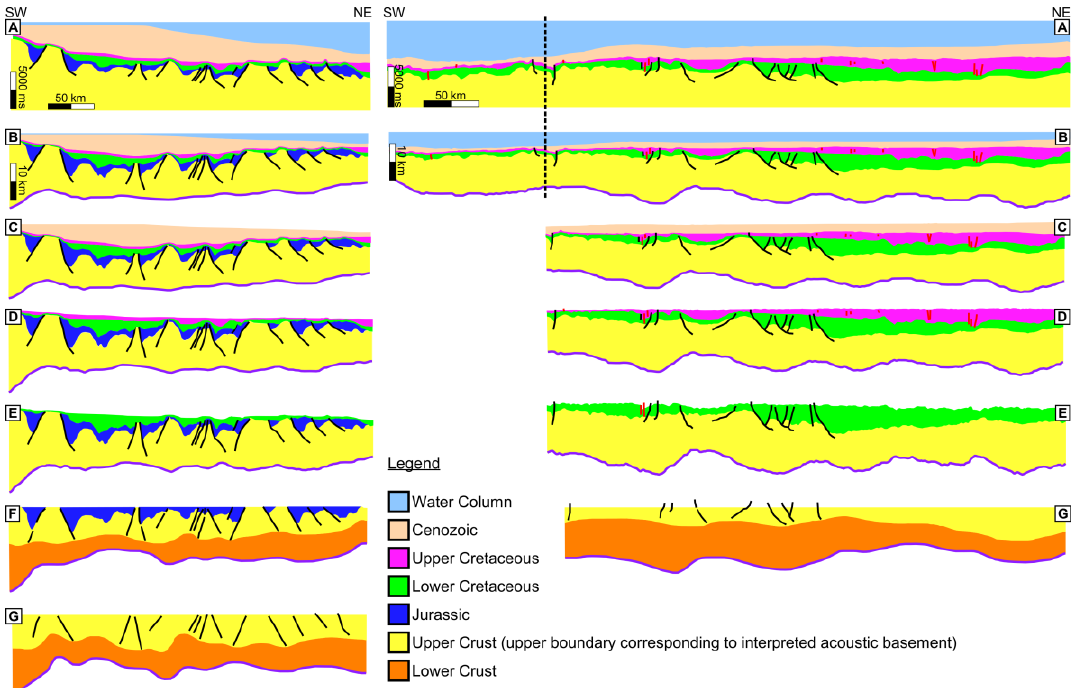
Figure 6. Left column shows the reconstruction of seismic line NL1 in the West Orphan Basin (blue line in Figure 1B). Right column shows the reconstruction of seismic line IR1 in the Rockall Basin (blue line in Figure 1C). ( A ) Seismic lines NL1 and IR1 in the time domain. ( B ) Seismic lines NL1 and IR1 in the depth domain. ( C ) Seismic lines NL1 and IR1 showing the results of the Cenozoic sedimentary layer decompaction and restoration of thermal subsidence. ( D ) Seismic lines NL1 and IR1 showing the results of the Upper Cretaceous sedimentary layer decompaction and restoration of thermal subsidence. ( E ) Seismic lines NL1 and IR1 showing the results of the Lower Cretaceous sedimentary layer decompaction. ( F ) Seismic line NL1 showing the results of the Jurassic sedimentary layer decompaction, fault restoration and unfolding. ( G ) Seismic lines NL1 and IR1 showing the final reconstruction, after the rebound of the crust (which is bounded on the top by the interpreted acoustic basement), fault restoration and unfolding. Purple line represents the Moho proxy from [15].